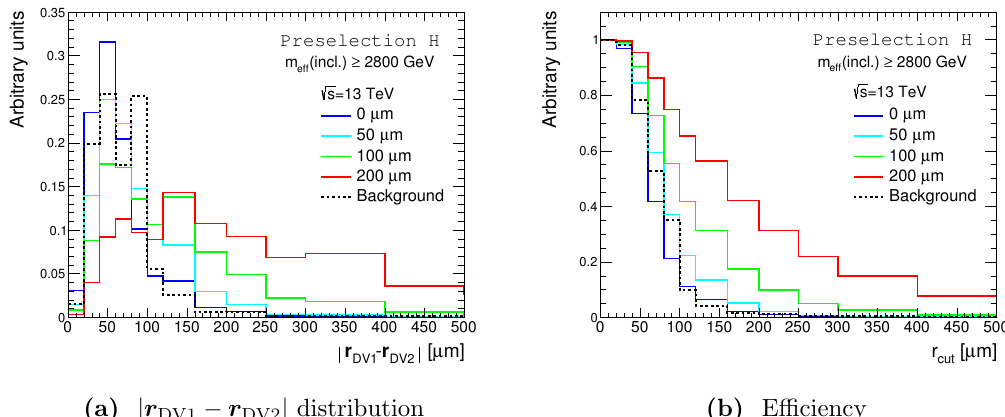
Figure 6. The distributions of j r r DV2 j > r cut for a gluino with m ~ g = 3 TeV and di(cid:11)erent values of c(cid:28) ~ g , shown in the solid lines.